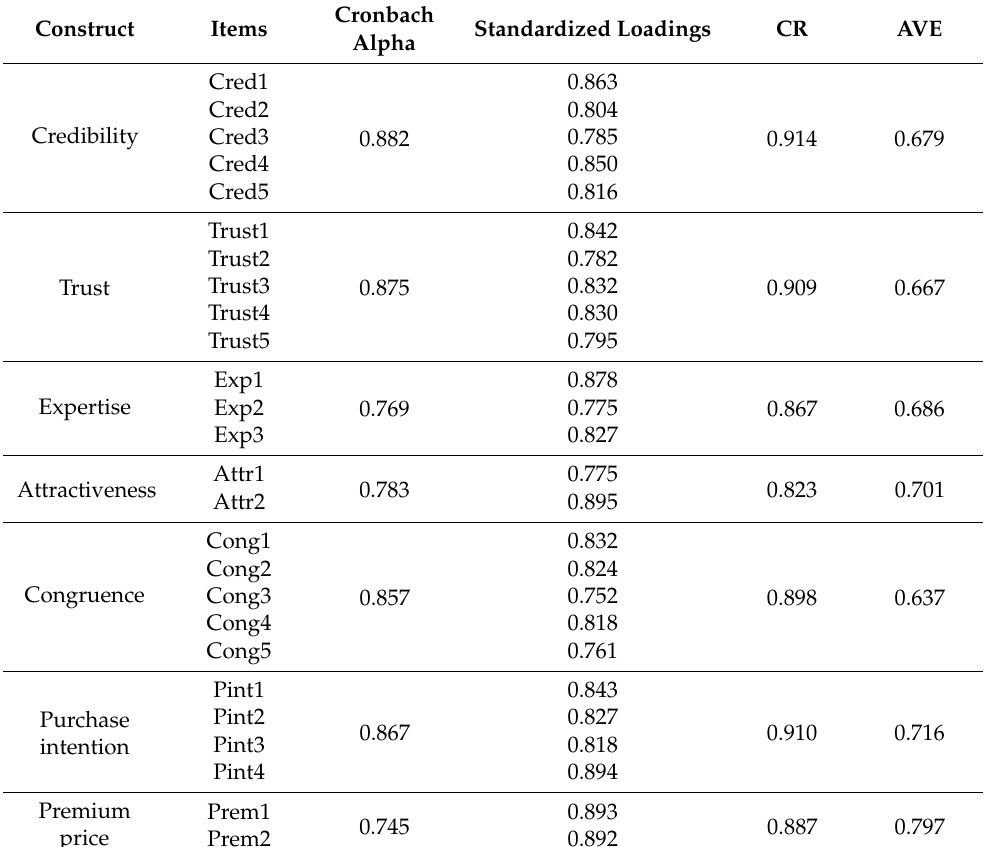
Table 3. Factor loadings and indicators of internal consistency and